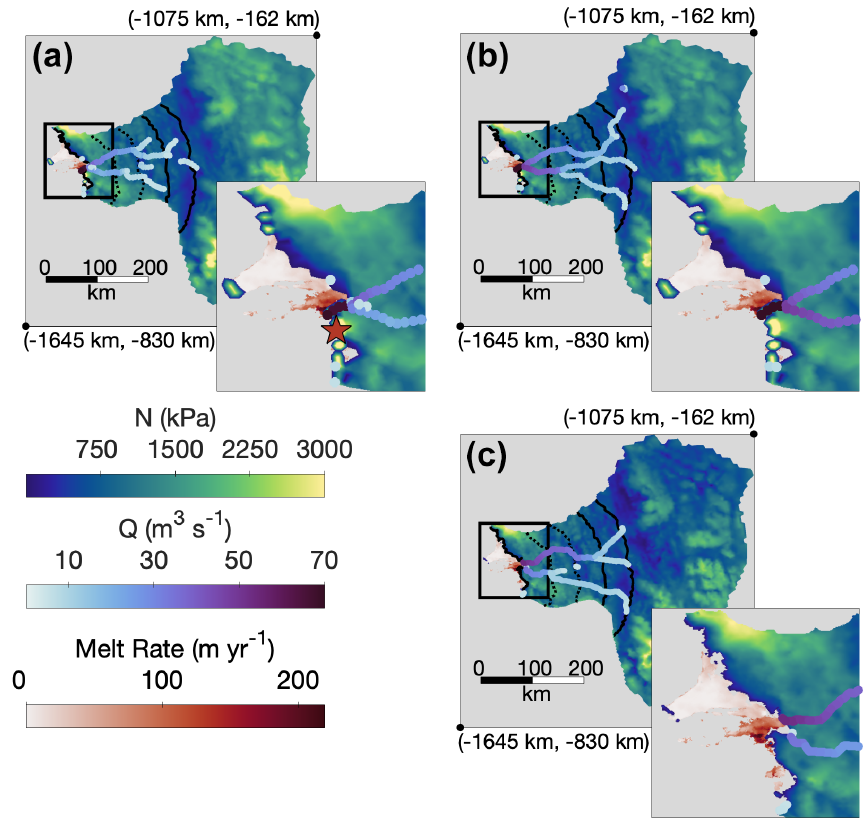
Figure 5. (a) Average effective pressure and channel discharge across all data-compatible FSS runs. (b–c) Effective pressure and channel discharge for (c) the high-resolution model and (b) its low-resolution counterpart. The insets are enlarged views of the black boxes, and the star in (a) indicates the location of the secondary channel seen in one data-compatible FSS run. Sub-ice-shelf melt rates from Adusumilli et al. (2020) are plotted in all frames. For clarity, only channels with Q > 5m 3 s − 1 are pictured in each frame. Again, transects spaced every 50km from the terminus (used for determination of flux steady-state and in Fig. 6) are shown as black lines, with the dotted lines spanning the transition zone of Schroeder et al. (2013). The locations of map corners are given in Standard Antarctic Polar Stereographic